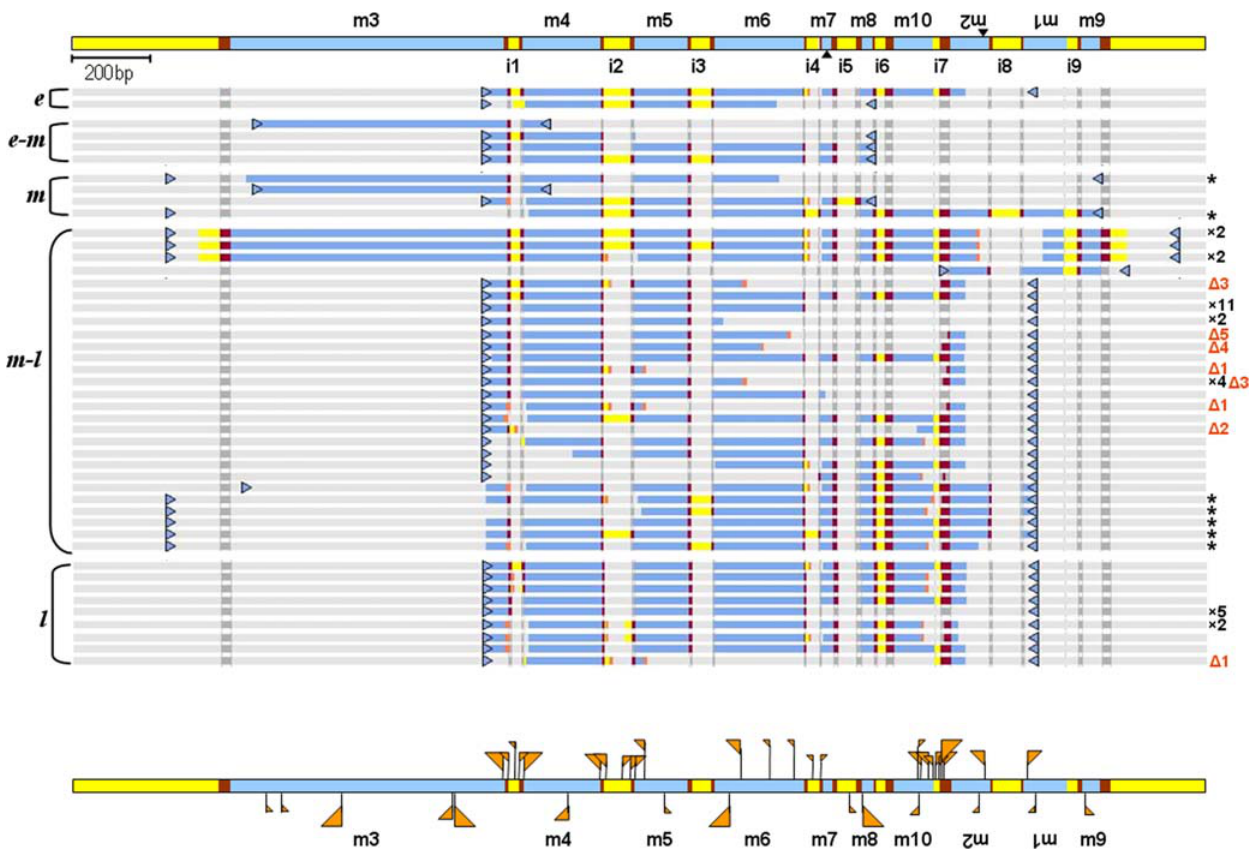
Figure 3. A schematic representation of all partially-processed S.lemnaeactinI molecules involving conventional DNA deletion junctions (IESs 1–5 and 8) at different stages of development (Figure 2). Regions not covered by amplified molecules are shown in gray (lighter gray for MDS/IES regions and darker gray for authentic pointers). Sequenced MDS regions are blue, IESs and flanking DNA in yellow and authentic pointers in maroon. Cryptic pointers used in some molecules are orange (details in Table S1A and Figure S2). Original PCR primers before nested PCR are shown as blue triangles for each molecule. * indicates sequences with primers in 5 9 flanking and 3 9 micronuclear gene sequence, described in the text. Numbers after an ‘‘x’’ indicate redundancy of some sequences; orange numbers after a D indicate molecules with large deletions (details in Figure S2B). Aligned sequences are provided in Data S1 file ‘‘SlActinIConventional.fas’’. At the bottom of the figure is a summary of the locations of all cryptic pointers (orange flags) detected in all partially processed molecules. Flags above the molecule represent cryptic pointers flanking aberrant deletions that do not alter micronuclear order. Flags below the molecule represent cryptic pointers found at incorrectly reordered junctions. Flag size is proportional to the number of times each cryptic pointer was observed at a specific location; tallest flags for large deletions ( D 1–5).